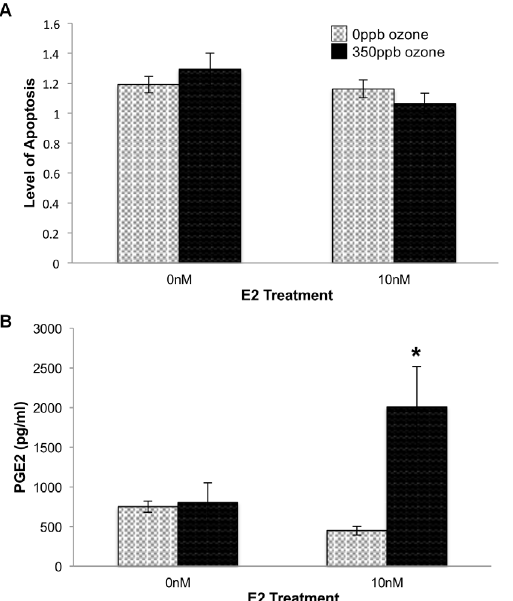
Figure 2. Effect of E2 and O 3 on relative levels of apoptosis (A) and PGE2 secretion (B) 0.5 hr after gas exposure. 10 4 L2 cells/ well were treated with E2 and O 3 as indicated. After 0.5 hr recovery time, levels of apoptosis (F=0.6948, df=3,12, p=0.5781) were determined and media samples were collected from a separate set of cells to determine PGE2 secretion (F=5.8628, df=3,11, p=0.0203). Level of apoptosis values represent the mean of 3–4 replicates normalized to data from control cells (-E2, in non-flowing 5% CO 2 /air), 6 S.E.M. PGE2 values represent the mean of 3 replicates, 6 S.E.M. # p # 0.05 compared to 0 ppb O 3 group and * p # 0.05 compared to the same E2 treatment group.